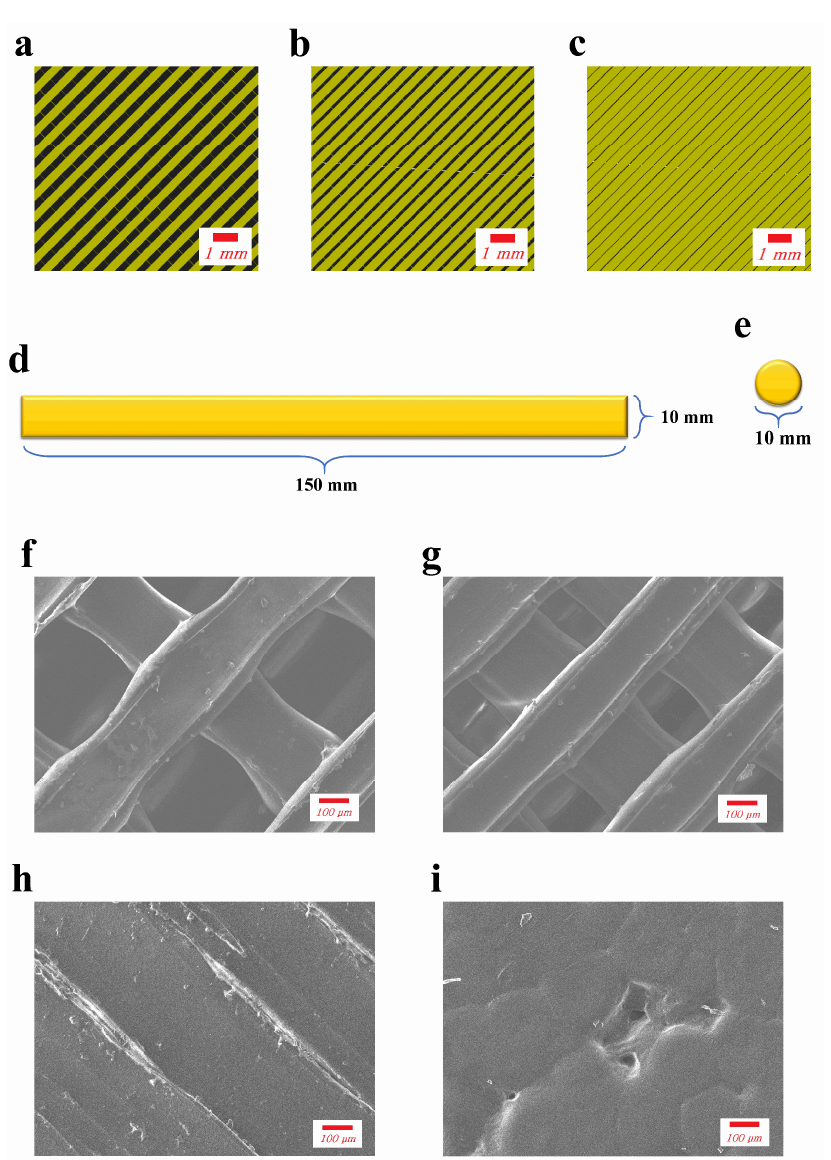
Figure 1. Models in slicing software program with ( a ) 60%, ( b ) 80% and ( c ) 100% infill rate; diagrams of specimens for ( d ) tensile test and ( e ) cell proliferation test; SEM images of ( f ) LP ( g ) SP ( h ) NP and ( i ) SC membranes.